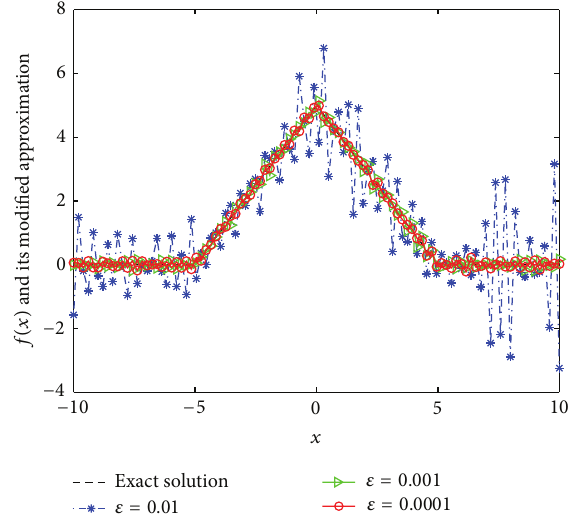
Figure 4: Comparison between the exact solution and its computed approximations with 𝑘 = 1 and various noise levels of 𝜀 = 0.1 , 𝜀 = 0.01 , 𝜀 = 0.001 for Example